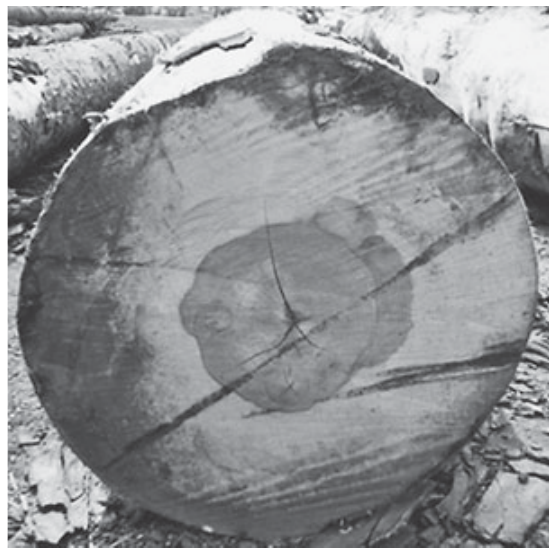
Figure 6 Analyzed log No. 52 Slika 6 . Analizirani trupac broj 52